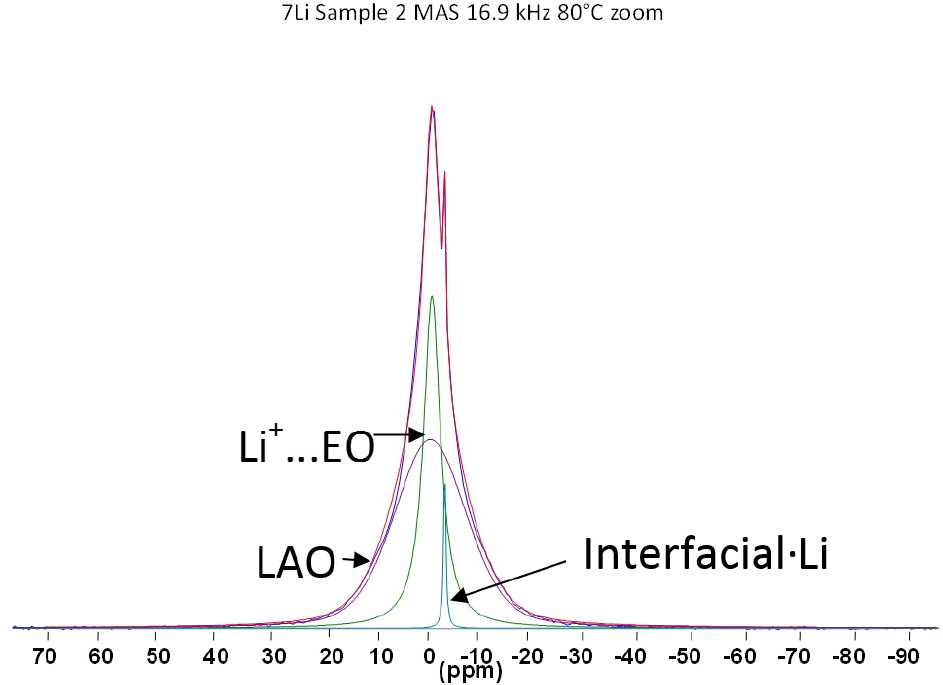
Figure 5. The 7 Li NMR high resolution MAS spectrum of 30 wt. % LiAlO 2 in PEO 2 LiI composite electrolyte at 80 °C; full spectrum plus spectral fits to components. Reproduced by permission of the Electrochemical